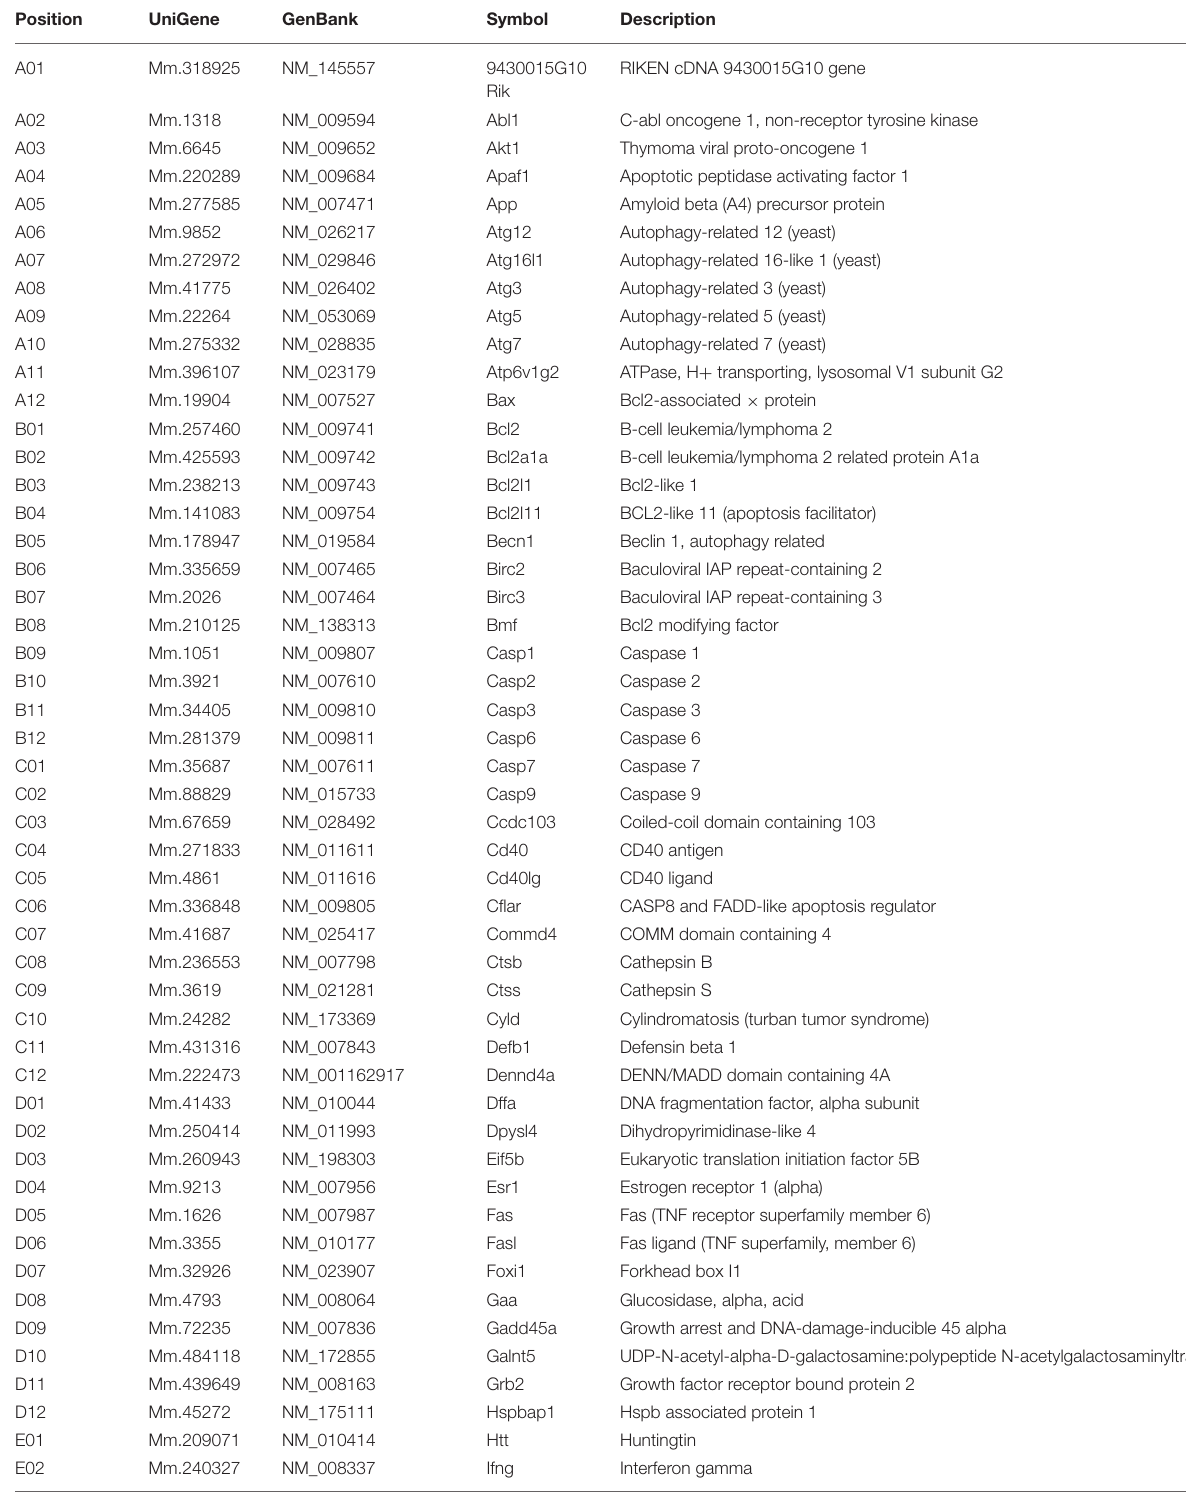
TABLE 1 | Gene table RT 2 PCR